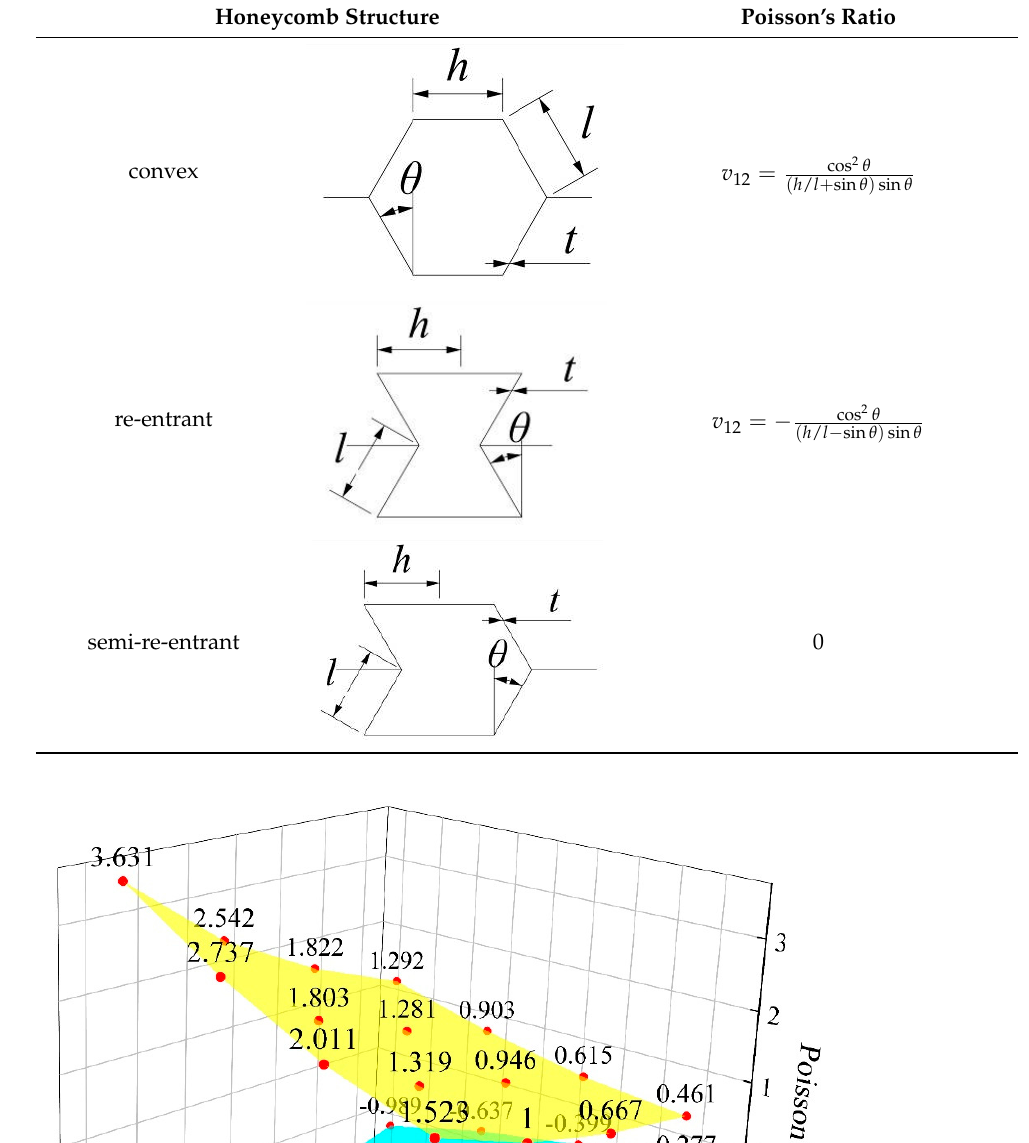
Table 1. Poisson’s ratio of three different honeycomb structures.